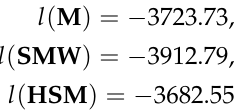
Table 4. AIC and BIC values.